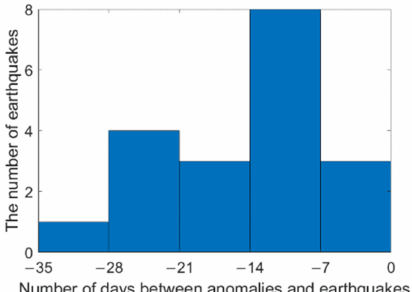
Figure 20. The number of days between anomalies and earthquakes.